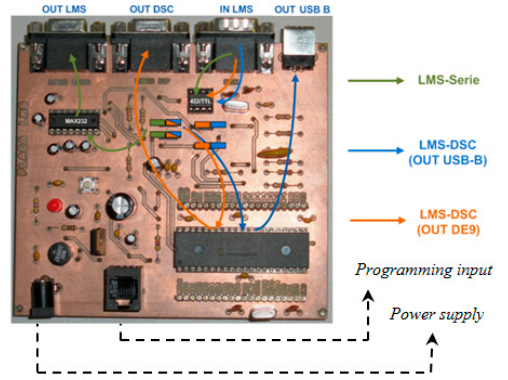
Figure 6. Printed circuit board (PCB) communications.